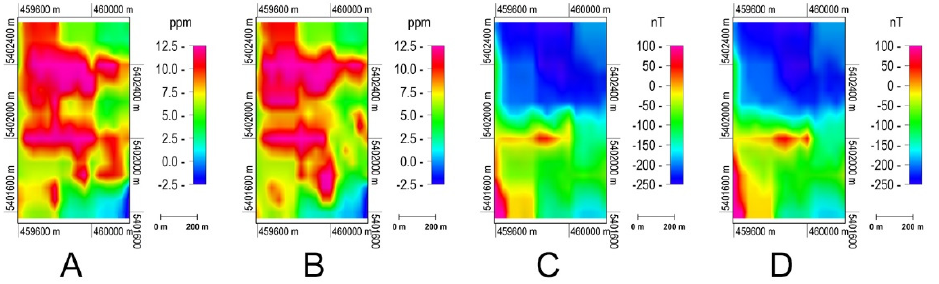
Figure 7. The Reid-Mahaffy test site. Panel ( A ) shows 1068 Hz coaxial component of the observed AEM data. Panel ( B ) shows the same component of AEM data predicted from Gramian joint inversion. Panel ( C , D ) show the observed TMI data and those predicted by Gramian joint inversion, respectively.